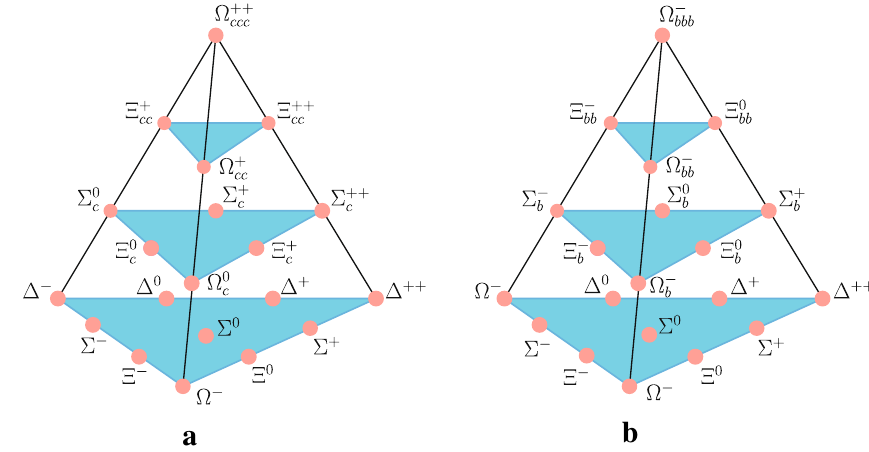
Fig. 1 Baryons with spin 3 / 2 made from four quarks of the types u , d , s , c ( a ) and u , d , s , b ( b ). Triply heavy baryons (cid:2) ++ ccc and (cid:2) − are localized in the bbb highest